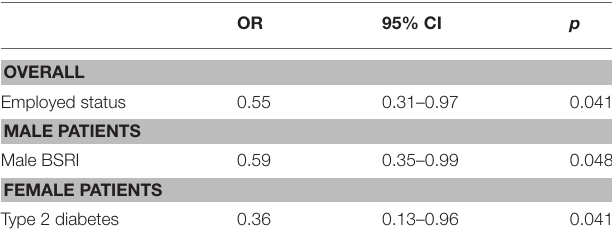
TABLE 5 | Multivariate logistic regression of pre-admission medication adherence in patients admitted for ischemic heart